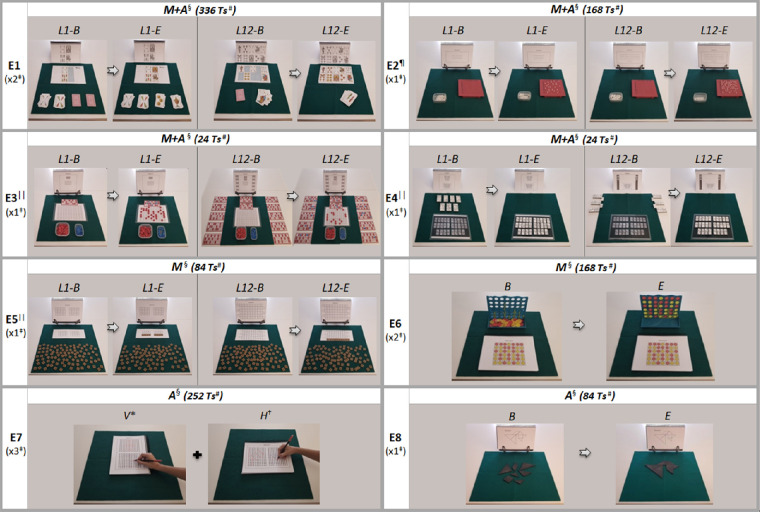
Examples of each included exercise (E) of the 3D-MCSTP. The E1–E5 images show the levels from lower (level [L] 1) to higher difficulty (L 12) at the beginning (B) and at the end (E) of the exercise. The images of E6 and E8 show the B and the E of the exercise because there were no pre-established levels of difficulty for them. E7 displays the two types of pattern copy, vertical (V) and horizontal (H). In all the images there is a green card mat that serves as a reference when properly placing the training materials on the worktable. *Patients should do one vertical sheet at each training session. In addition, the copy pattern alternates its position between the top and the bottom of the sheet every day. †Patients should do two horizontal sheets at each training session, and, in this case, the copy pattern position is customized according to the patient´s visual field defect to the right or to the left of the sheet. ‡The number of training sheets that a patient had to complete in each daily session. §It is specified whether the patients had to perform the exercise in the morning session (M), in the afternoon session (A), or in both (M + A). # The total number of different training sheets incorporated in the 3D-MCSTP for each type of exercise to avoid learning effect. ¶The 10 × 10 grid position was customized according to the patient's visual field defect. ||The positions of the bingo cards (E3), dominoes (E4), and the 100 plastic pieces with letters (E5) changed positions between the top and bottom of the card mat between training sessions.